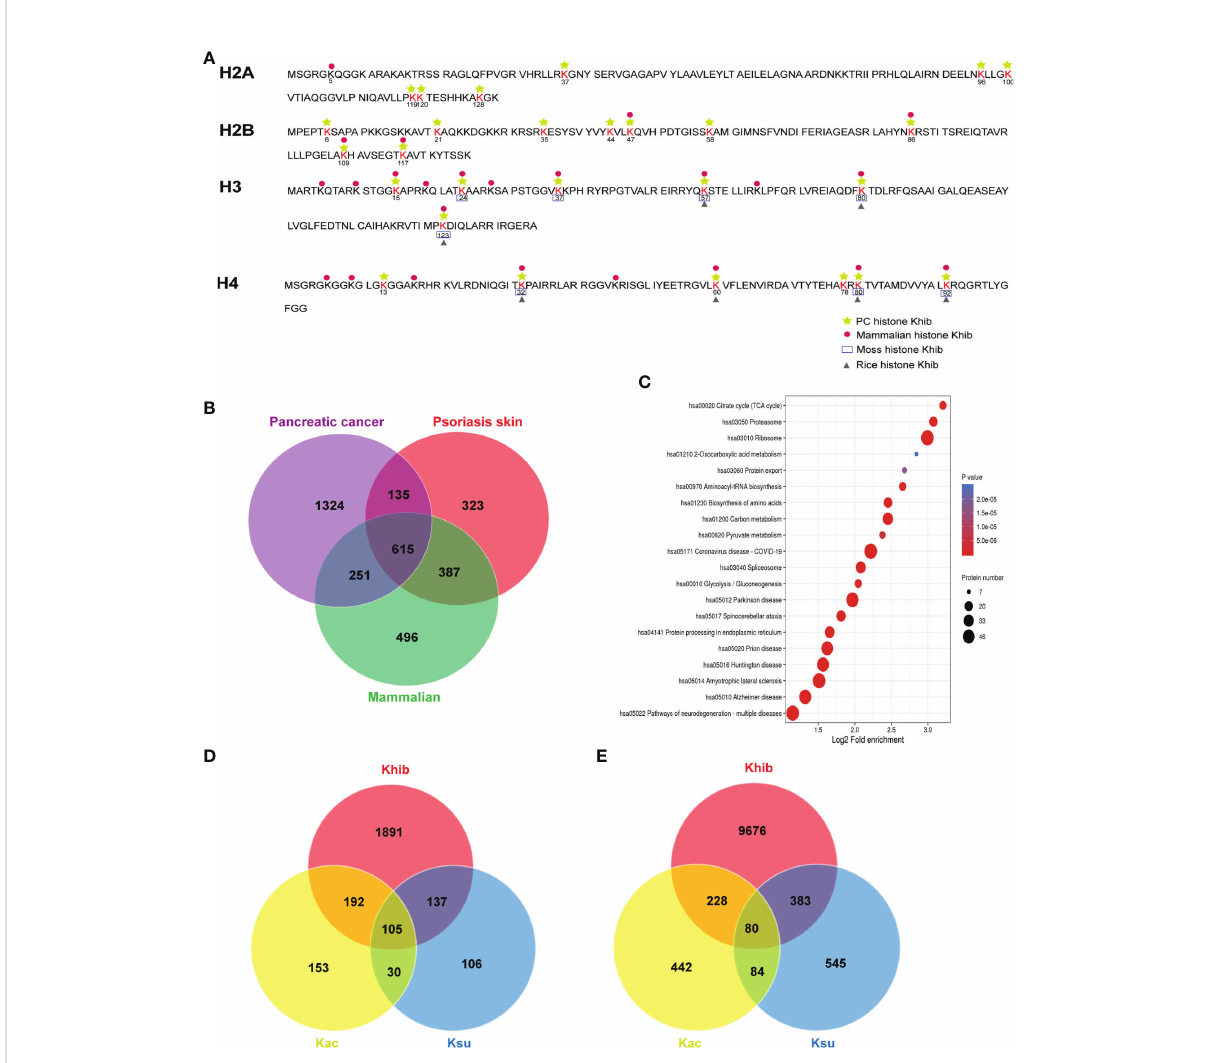
FIGURE 4 Conservation and uniqueness of the 2-hydroxyisobutyrylation (K hib ) proteins in human pancreatic cancer (PC). (A) The comparison of the K hib histones in diverse species. (B) The number of overlapping K hib proteins among PC, psoriasis skin, and mammalian cells. (C) Kyoto Encyclopedia of Genes and Genomes (KEGG) analysis of the common K hib proteins in PC, psoriasis skin, and mammalian cells. (D) The number of overlapping proteins among K hib , lysine succinylation (K su ), and lysine acetylation (K ac ). (E) The number of overlapping modi fi ed sites among K hib , K ac , and K su